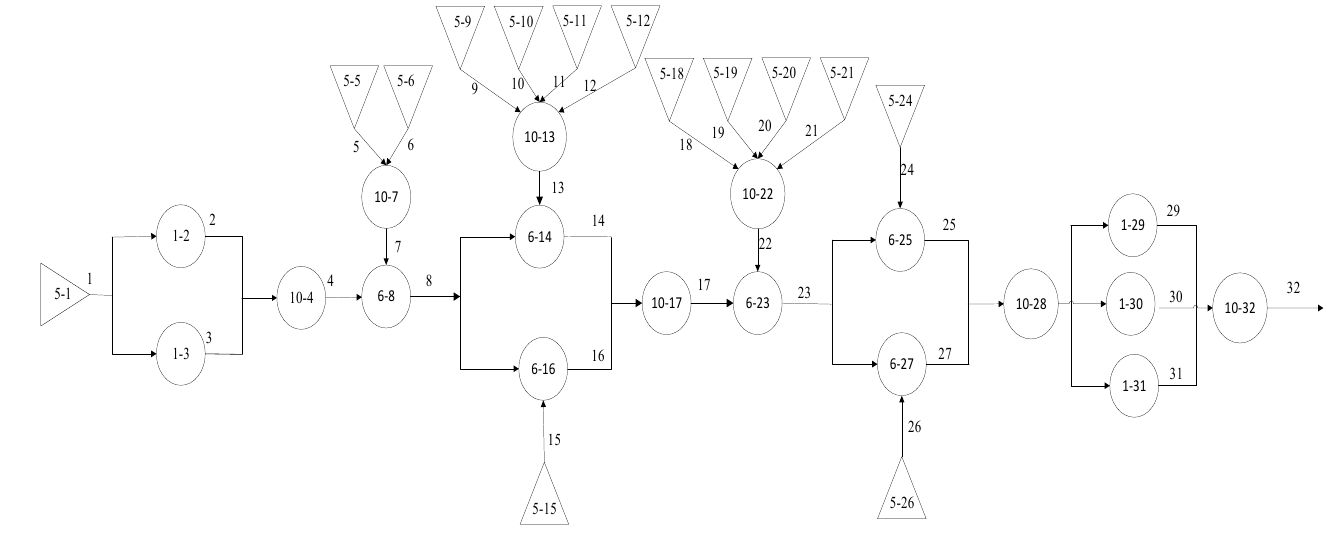
Figure 11. Go diagram of the smart meter.